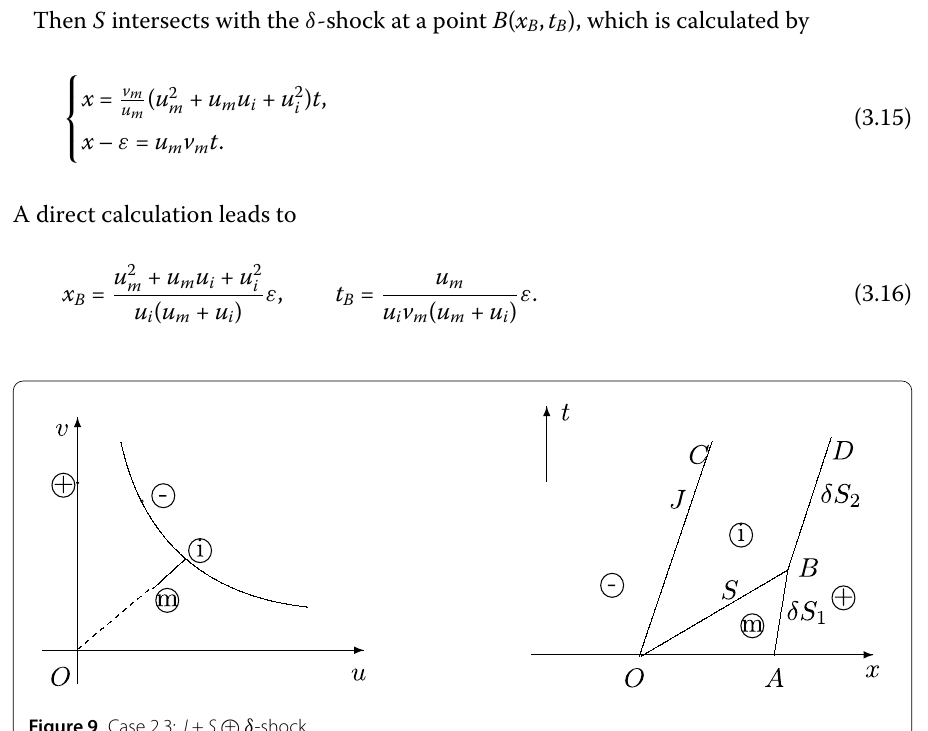
Figure 9 Case 2.3: J + S + (cid:10) δ